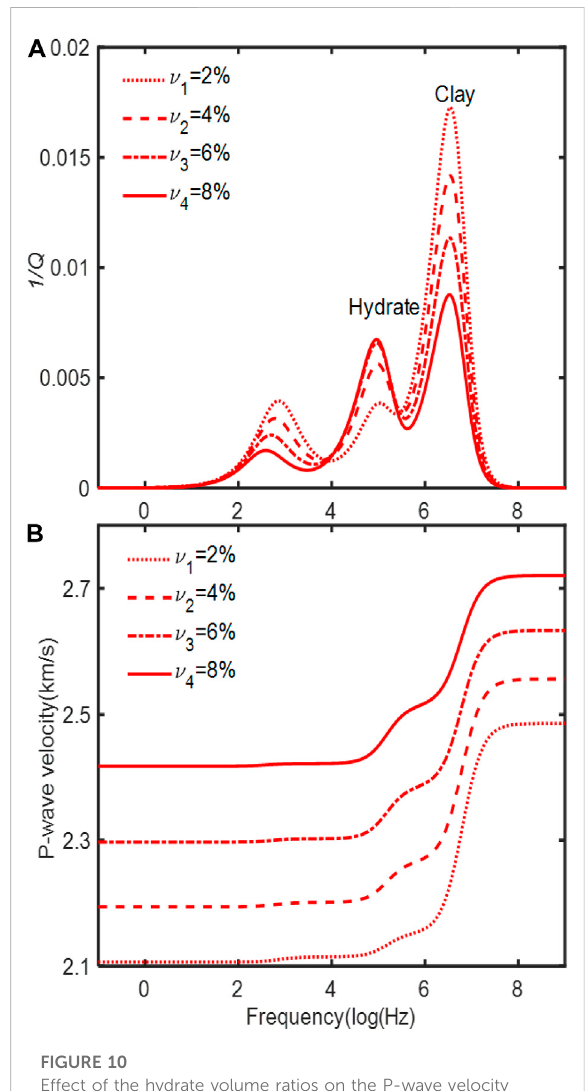
dispersion (A) and attenuation (B) . The radius of the hydrate inclusionsis R 12 =0.005 cm,andtheradiusoftheclayinclusionsis R 23 = 0.05